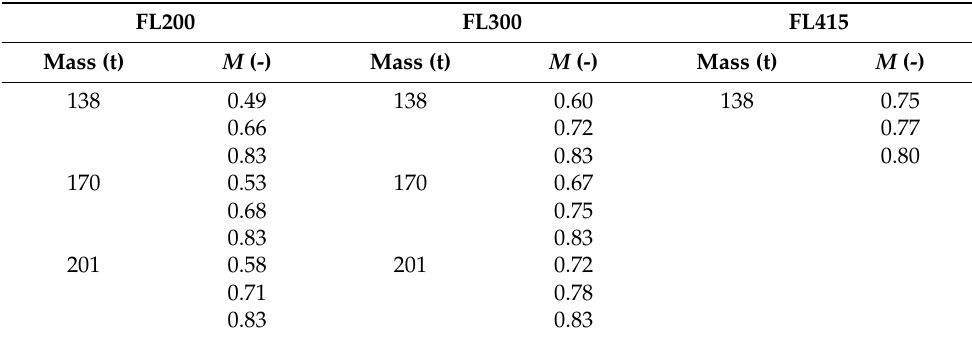
Table A1. Realistic flight operation conditions for A330-301 at FL200, FL300, and FL415.